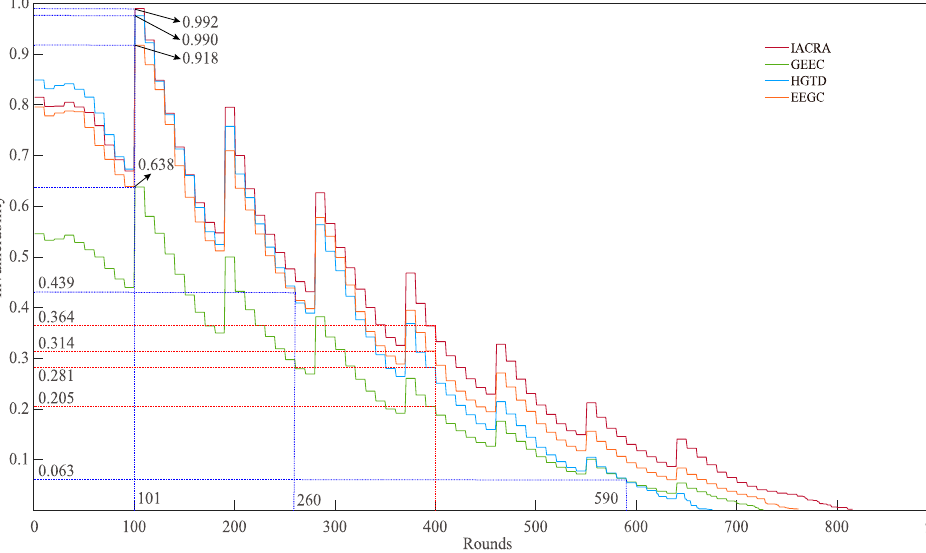
Figure 10. Comparisons of invulnerability of IACRA, GEEC, HGTD, and EEGC.